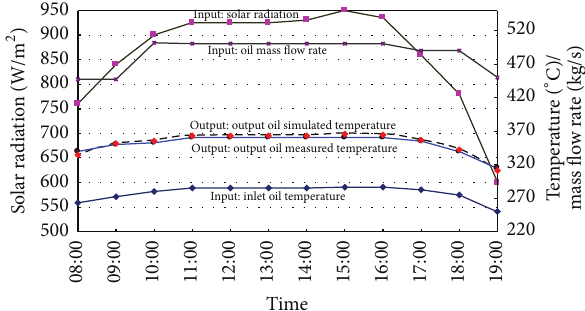
Figure 6: Comparison of simulated and measured results in sum- mer working